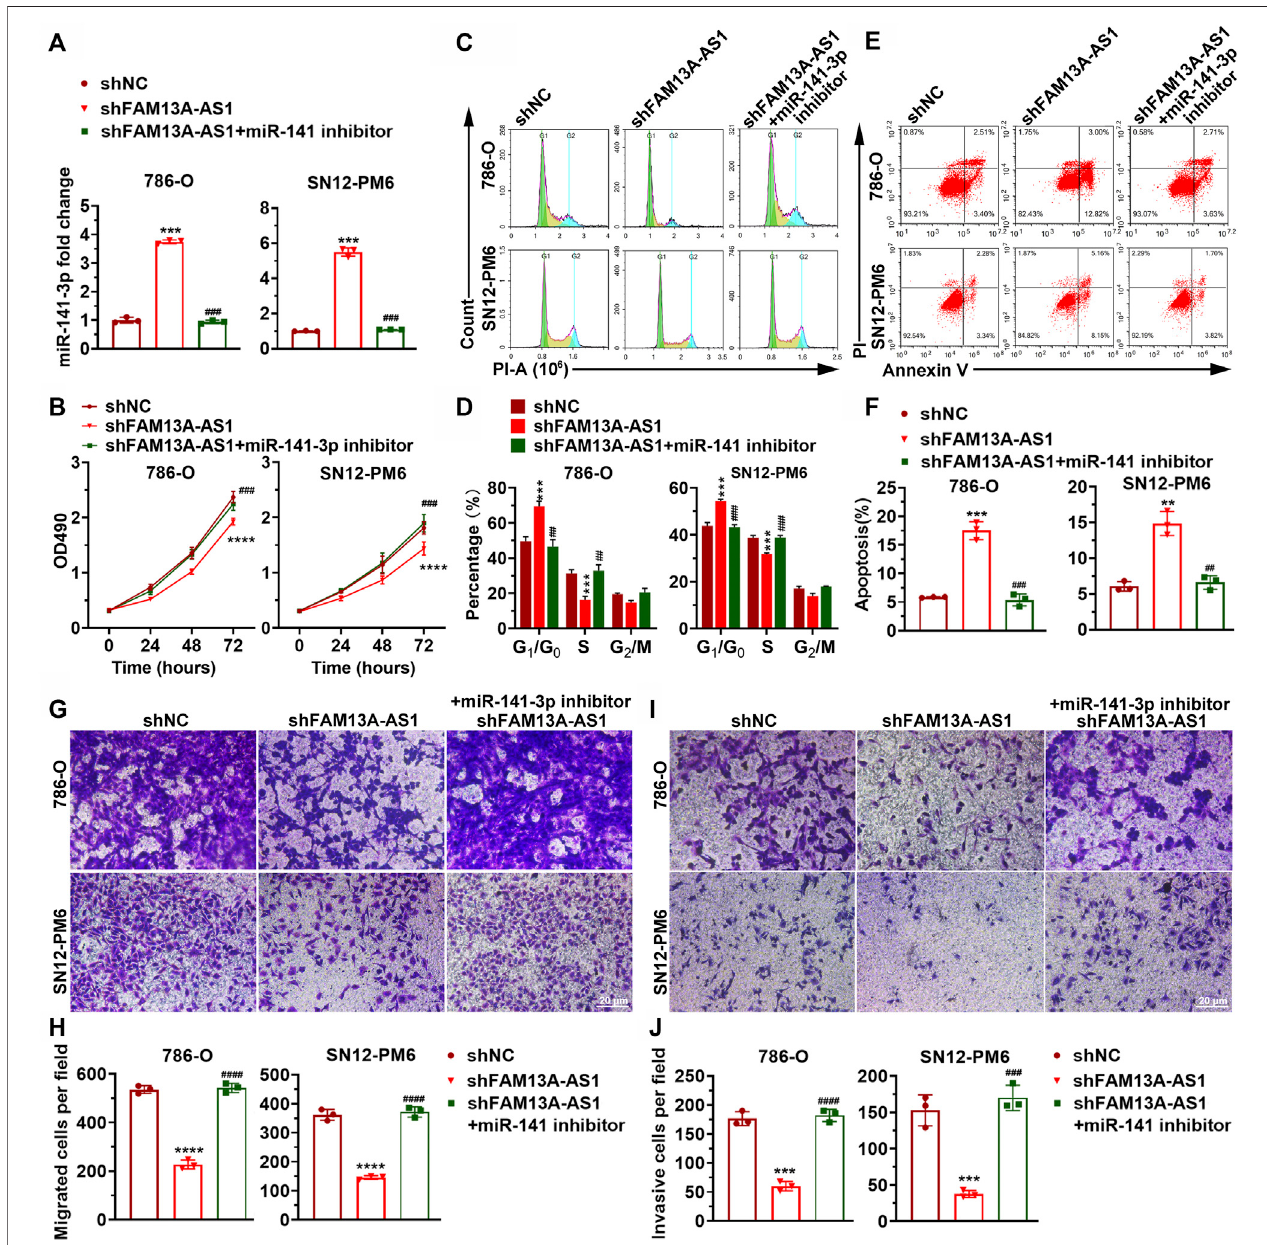
FIGURE 4 | miR-141-3p inhibits kidney cancer cell proliferation, migration, and invasion. (A) Bar plot showing the expression level of miR-141-3p in RCC cells co- transfected with shFAM13A-AS1 or scrambled control treated with either miR-141-3p. (B) MTT assay of RCC cells transfected with shFAM13A-AS1 treated with either miR-141-3p inhibitor or negative controls. (C,D) Representative images (C) and quanti fi cation (D) of cell proliferation assay in RCC cells. Edu-positive cells: green. Cell nuclei: blue. (C,D) Representative histograms (C) and quanti fi cation (D) of cell cycle distribution of RCC cells. X and Y axes (C) denote DNA content and cell number, respectively. Bar plot (D) shows the percentages of cells at different stages during the cell cycle. (E,F) Representative dot plots (E) and quanti fi cation (F) of Annexin V/PI two-parameter fl ow cytometry analysis of RCC cells. Bar plot (lower) shows the percentages of cells that undergo apoptosis. The RCC cell lines were transfected with shFAM13A-AS1 or scrambled control and treated with miR-141-3p inhibitor. (G,H) Representative images (G) and quanti fi cation (H) of the transwell migration assay in RCC cells transfected or treated with miR-141-3p inhibitor. (I,J) Representative images (I) and quanti fi cation (J) of the matrigel invasion assay in the above cells. Data represent the mean ± SD. ***: p < 0.001; ****: p <